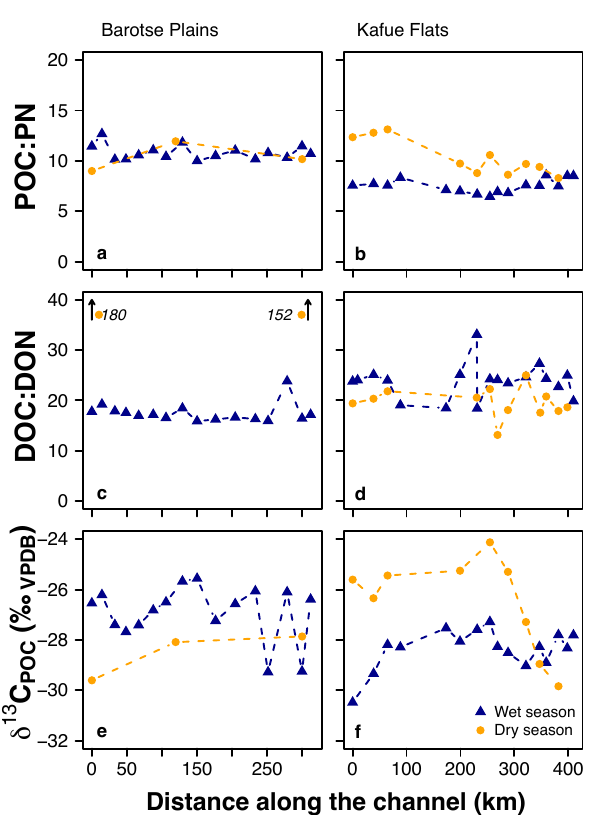
Figure 6. Carbon to nitrogen (C:N) ratios of particulate and dis- solved organic matter as well as carbon isotopic signatures of par- ticulate organic matter during wet (blue triangles) and dry (orange circles) seasons. The Kafue Flats data have been previously pub- lished in Zurbrügg et al.